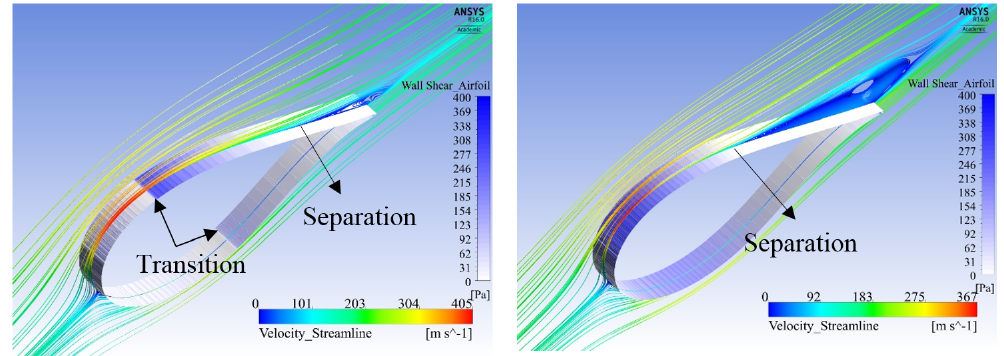
Figure 7. Flow streamlines and wall shear stress; with a fully turbulent boundary layer ( right ), and laminar-turbulent boundary layer ( left